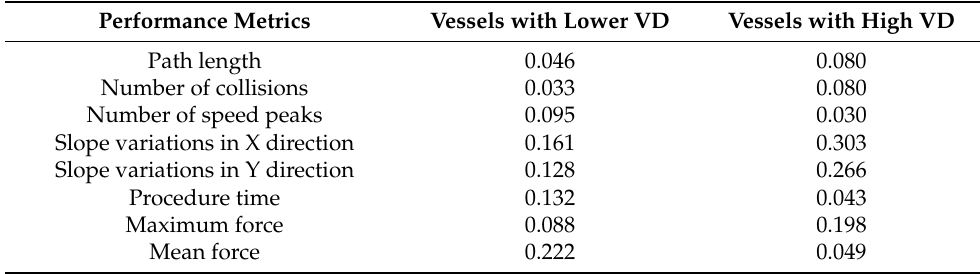
Table 2. The significance of the differences between the manipulation data of different skill groups for the same vascular difficulty ( p